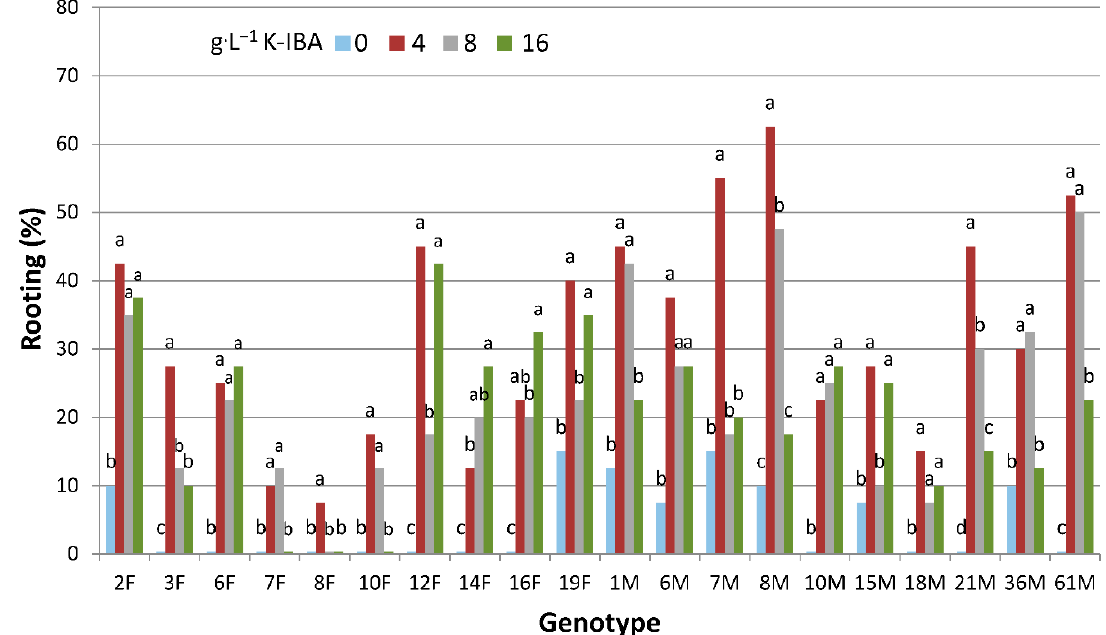
Figure 2. Effect of different concentrations of K-IBA on rooting (%) of shoot cuttings of ten male and ten female genotypes of P. lentiscus var. Chia in winter. Different letters in each genotype indicate statistically significant differences among the concentrations of K-IBA tested according to Duncan’s multiple range test at p ≤ 0.05.